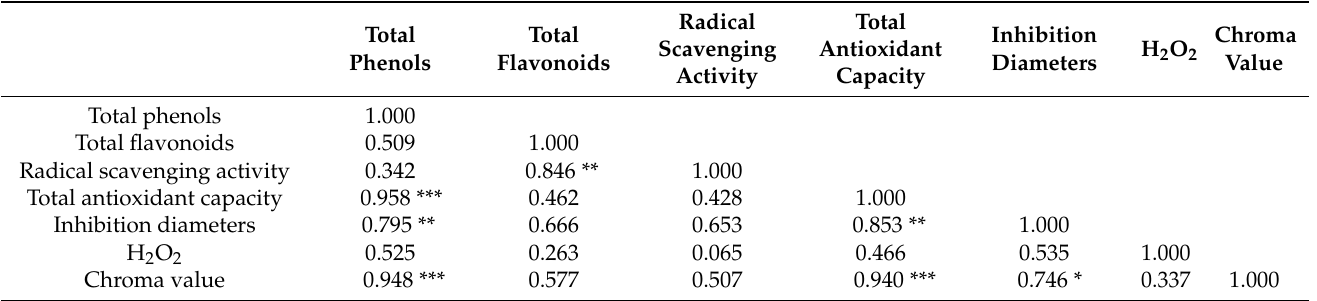
Table 6. Correlation analysis between indicators of Chinese